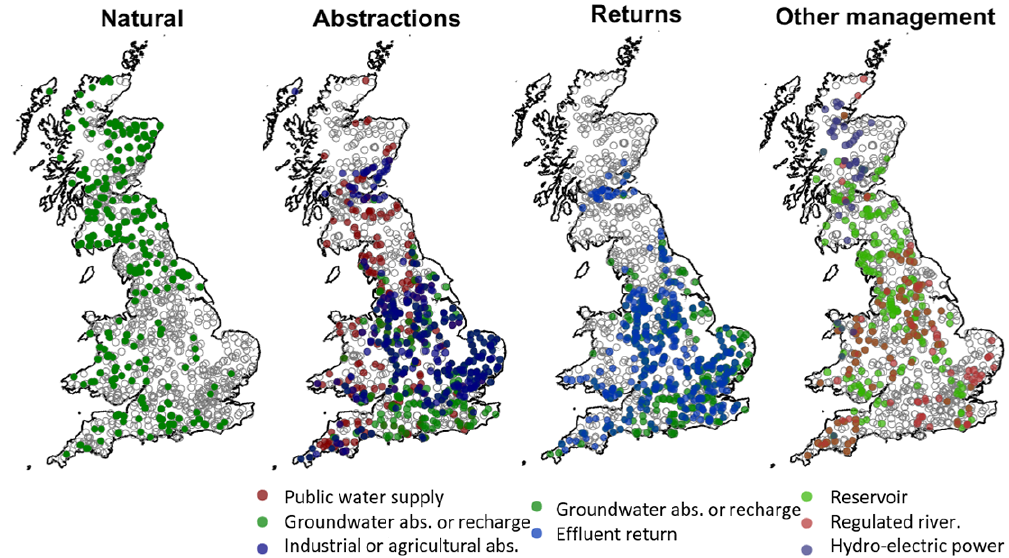
Figure 1. Factors affecting runoff in the study catchments, using information from the UK hydrometric register. Natural catchments are defined as having limited variation from abstractions and/or discharges so that the gauged flow is within 10% of the natural flow at or above the Q 95 flow. The groundwater category includes both groundwater abstraction and recharge as well as the few catchments where mine-water discharges influence flow. Full descriptions of all factors can be found in the UK hydrometric register (Marsh and Hannaford, 2008b). Table 1. Characteristics of the 1013 catchments included in this study. Values for mean annual rainfall, runoff, loss, flood peaks and peak daily flows were calculated from the model input time series. Other values were taken from the UK hydrometric register (Marsh and Hannaford, 2008b). Variable 95th percentile Median 5th percentile Catchment area ( km 2 ) 1299 135 17 Baseflow index ( – ) 0.86 0.47 0.30 Mean annual rainfall ( mm ) 2332 975 618 Mean annual runoff ( mm ) 1912 525 146 Mean annual loss ( mm )